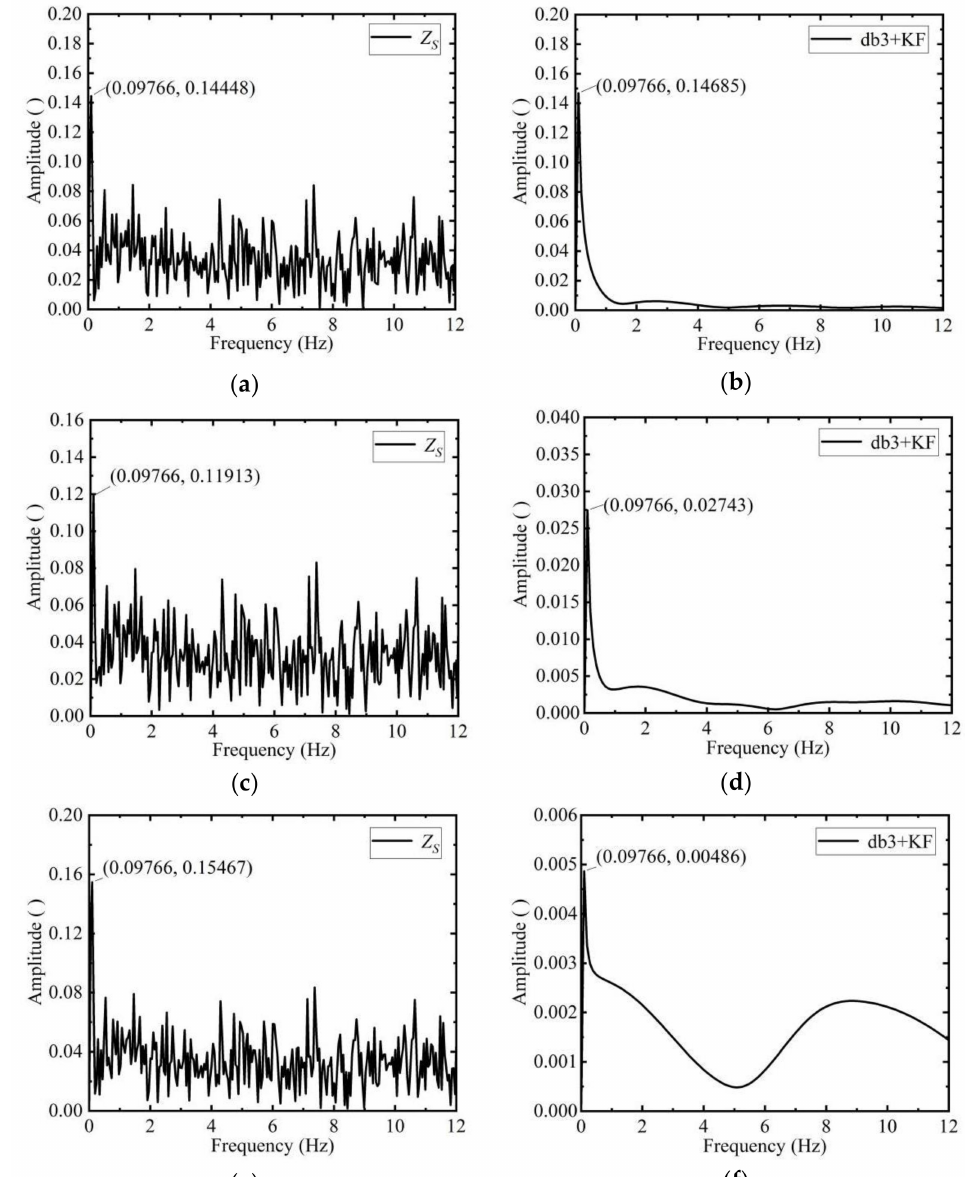
Figure 5. Spectrum analysis before and after filtering of the SINS angular velocity. ( a ) Spectrogram of observation values of the ω x ; ( b ) Spectrogram of filter values of the ω x ; ( c ) Spectrogram of observation values of the ω y ; ( d ) Spectrogram of filter values of the ω y ; ( e ) Spectrogram of observation values of the ω ω z ; ( f ) Spectrogram of filter values of the z